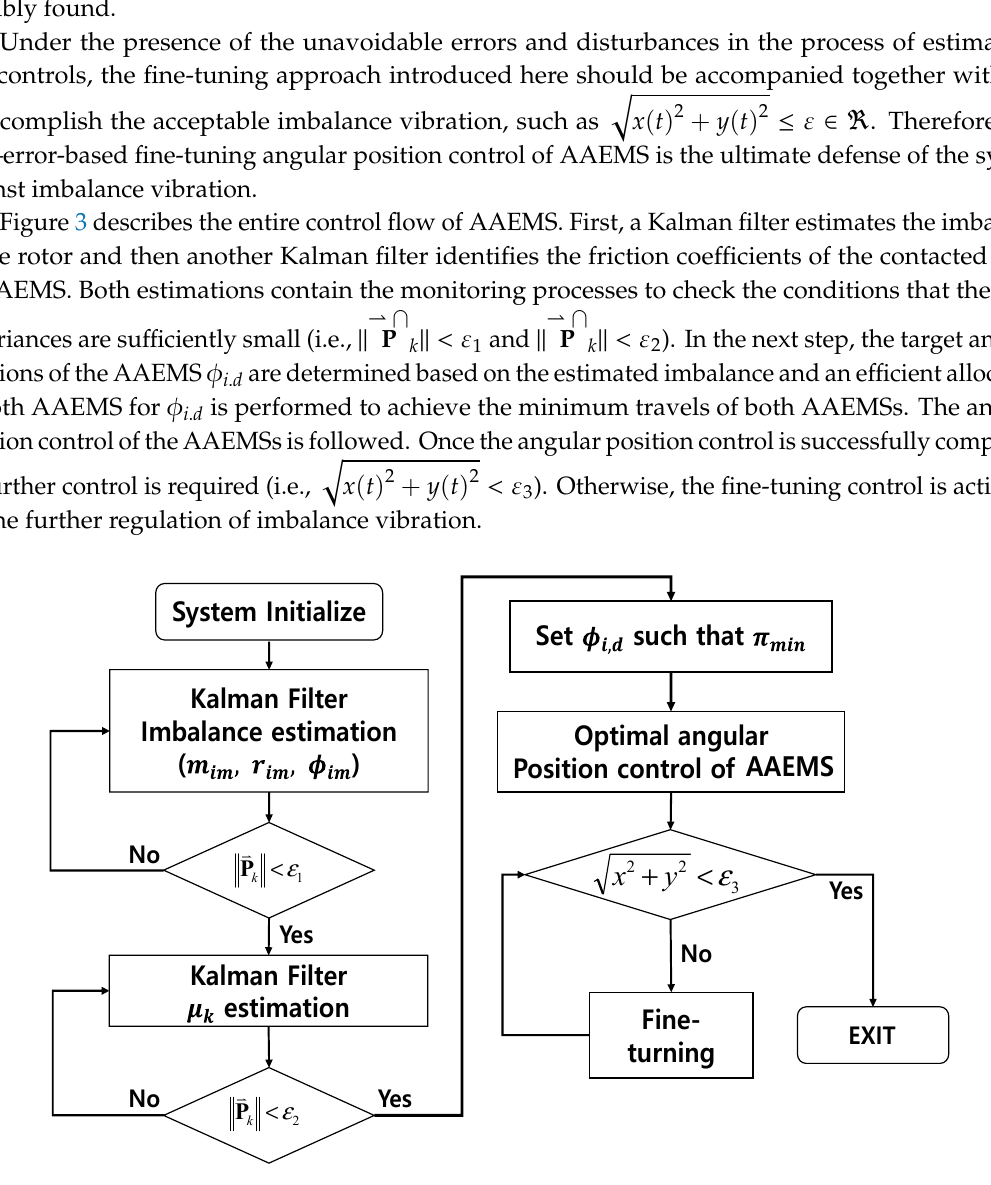
Figure 3. Entire estimation and control flows of AAEMS.